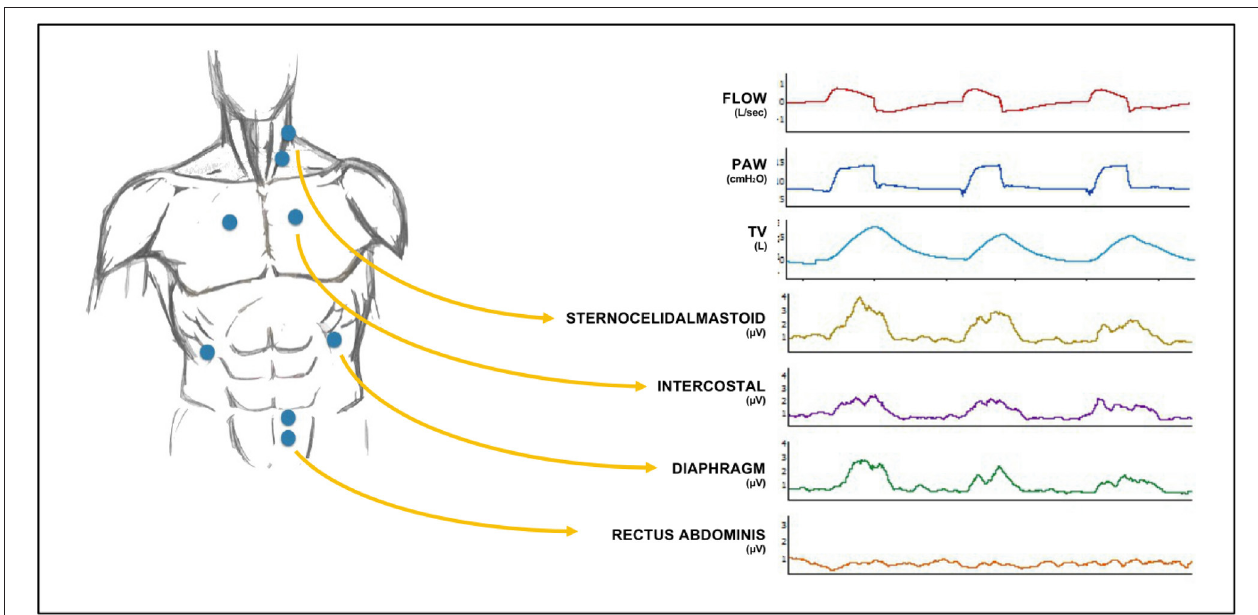
FIGURE 1 | Electrode positioning on the chest wall (left) and general setup of the channel recordings (right) along with sample ventilatory waveforms and surface electromyography (sEMG) traces. The four pairs of electrodes were positioned (1) on the lower coastal margin, bilaterally on the midclavicular line, for diaphragm electrical activity (EAdi surf ), (2) on the second intercostal space, bilaterally on the parasternal line, for parasternal external intercostal muscles EA, (3) on the middle third of the sternocleidomastoid muscle, for sternocleidomastoid EA and (4) on the left midclavicular line, at the level of the umbilicus, for rectus abdominis muscles EA. PAW, Airway Pressure; TV, Tidal